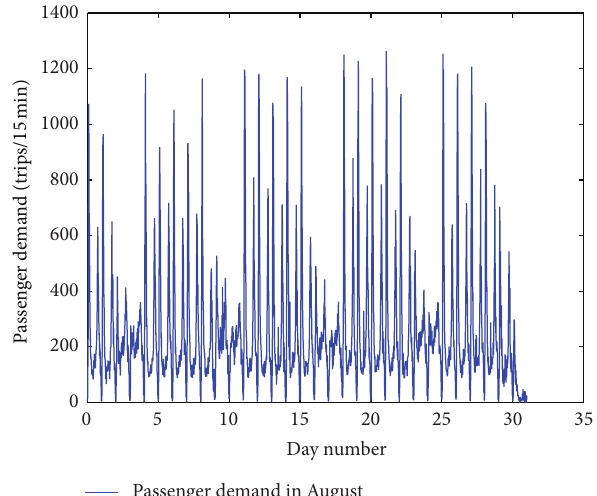
Figure 1: Passenger demand in August